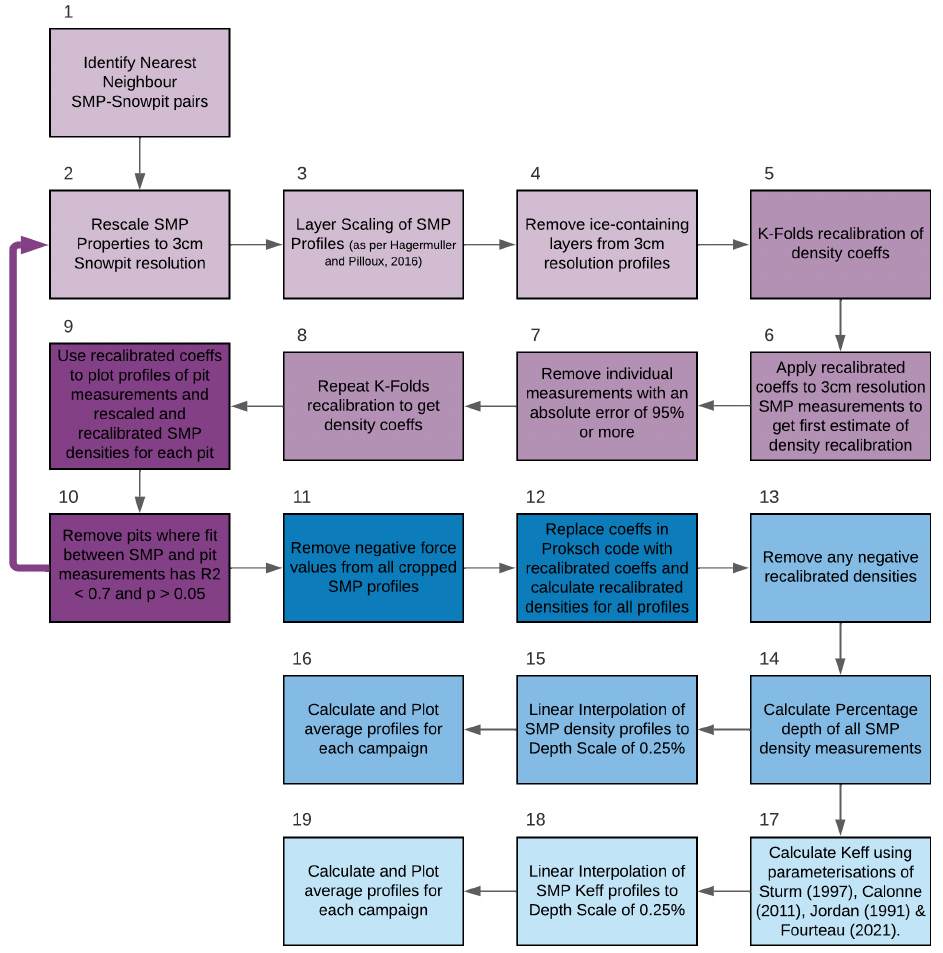
Figure A1. Recalibration process for SMP densities. Steps 2–9 (purple) mirror the process of King et al. (2020b), with step 10 providing a quantitative threshold to assess whether the recalibration attempt is successful. Steps 11 to 19 (blue) apply the recalibration to the TVC dataset and derive thermal conductivity profiles from the recalibrated SMP densities. Step 17 refers to Sturm et al. (1997), Calonne et al. (2011), Jordan (1991) and Fourteau et al. (2021b).